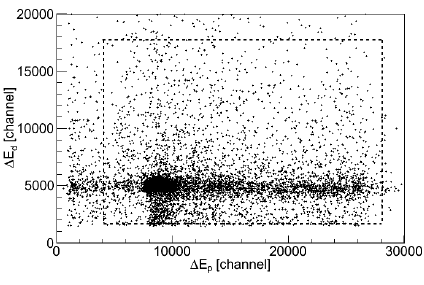
Figure 3. The time di ff erence of the signals ap- pearance from the deuteron and proton counters at scattering for θ c . m . = 75 ◦ at 500 MeV /